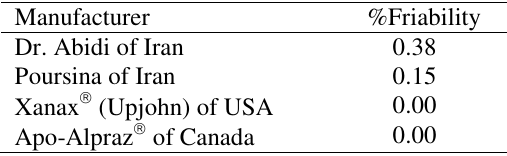
Table 2 . Results obtained from friability